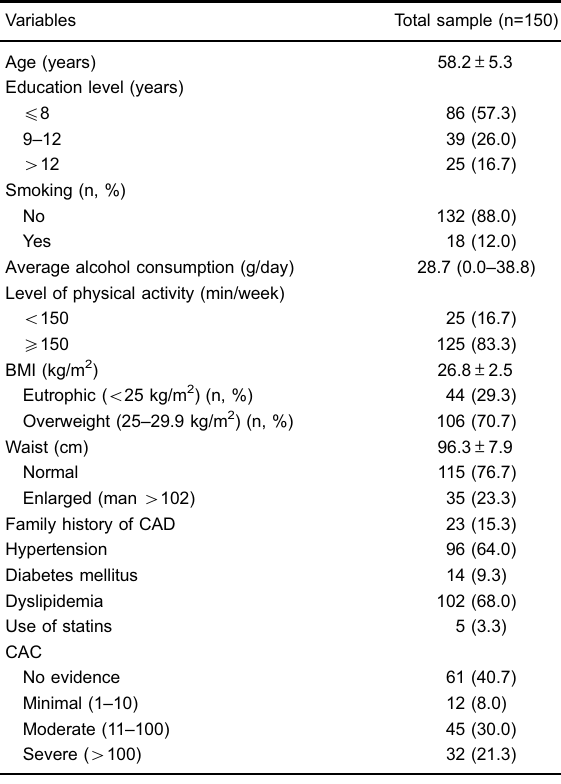
Table 1. Characteristics of the study